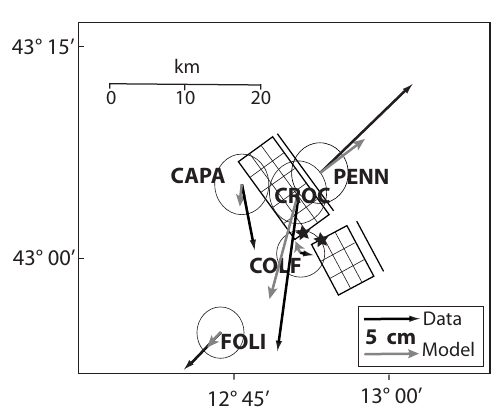
Fig. 2. Geometry assumed by Hernandez et al . (2004) for the sources of events 1 and 2. GPS data of horizontal displacement recorded in near field sta- tions are compared to model results (best model ac- cording to both DInSAR data and GPS data). The figure shows only five out of twelve GPS stations used in the inversion (see text). The epicentres of events 1 and 2 are indicated with black stars. The fault discretization used is also shown in map view. The solid lines parallel to fault strikes represent the intersections of the prolongation of the fault planes with the Earth surface. The top edge depth of the fault of event 2 is fixed to 700 m. The crustal model assumed is reported in Table I. Figure modified from Hernandez et al .